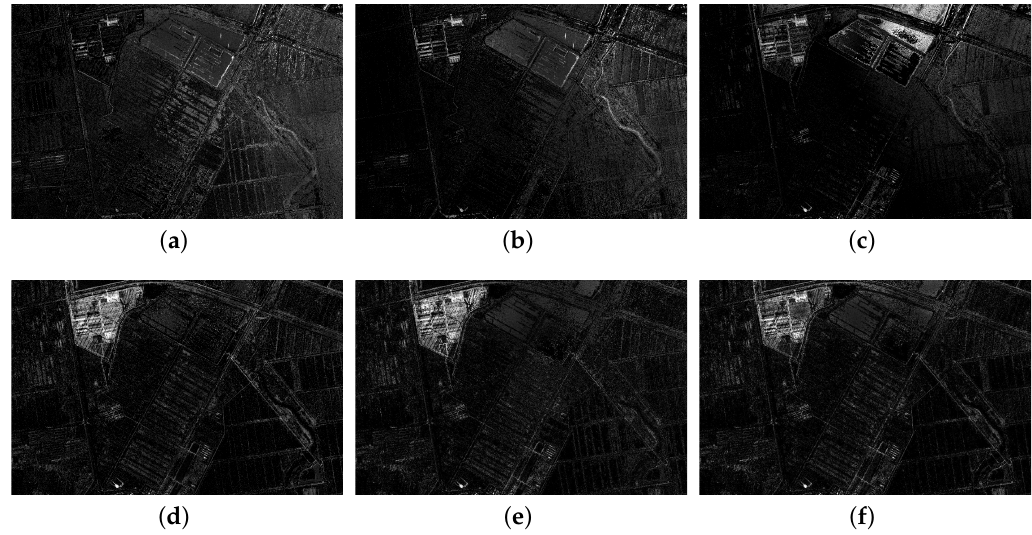
Figure 19. The difference images for the Shuguang Village dataset obtained according to different numbers of selected pixels. ( a ) Difference image when the number is k /3. ( b ) Difference image when the number is k /4. ( c ) Difference image when the number is k /11. ( d ) Difference image when the number is k /23. ( e ) Difference image when the number is k /25. ( f ) Difference image when the number is k